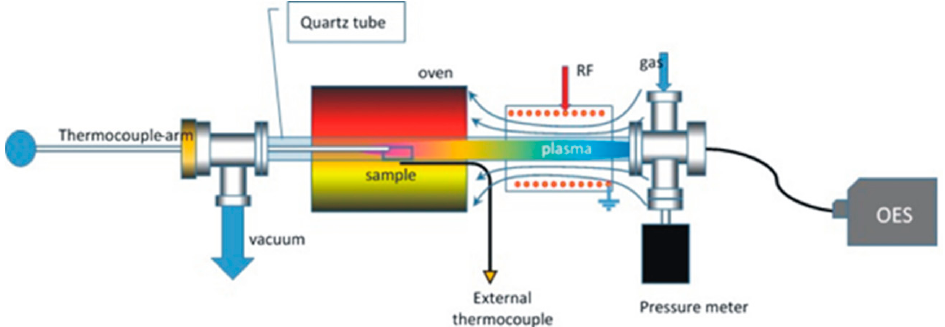
Figure 1. Schematic drawing of the ICP-CVD tubular reactor for producing carbon structures. The reactor is composed of a quartz tube, an oven, and a coil connected to an RF power supply. The sample is placed in the middle of the oven. The system is evacuated with a primary rotatory pump and the pressure were analyzed with a pressure meter. The temperature is measured by means of two thermocouples. Different gases can be introduced through an inlet at one end of the quartz tube. OES: Optical Emission Spectroscopy device to study the emission of plasma generated species.